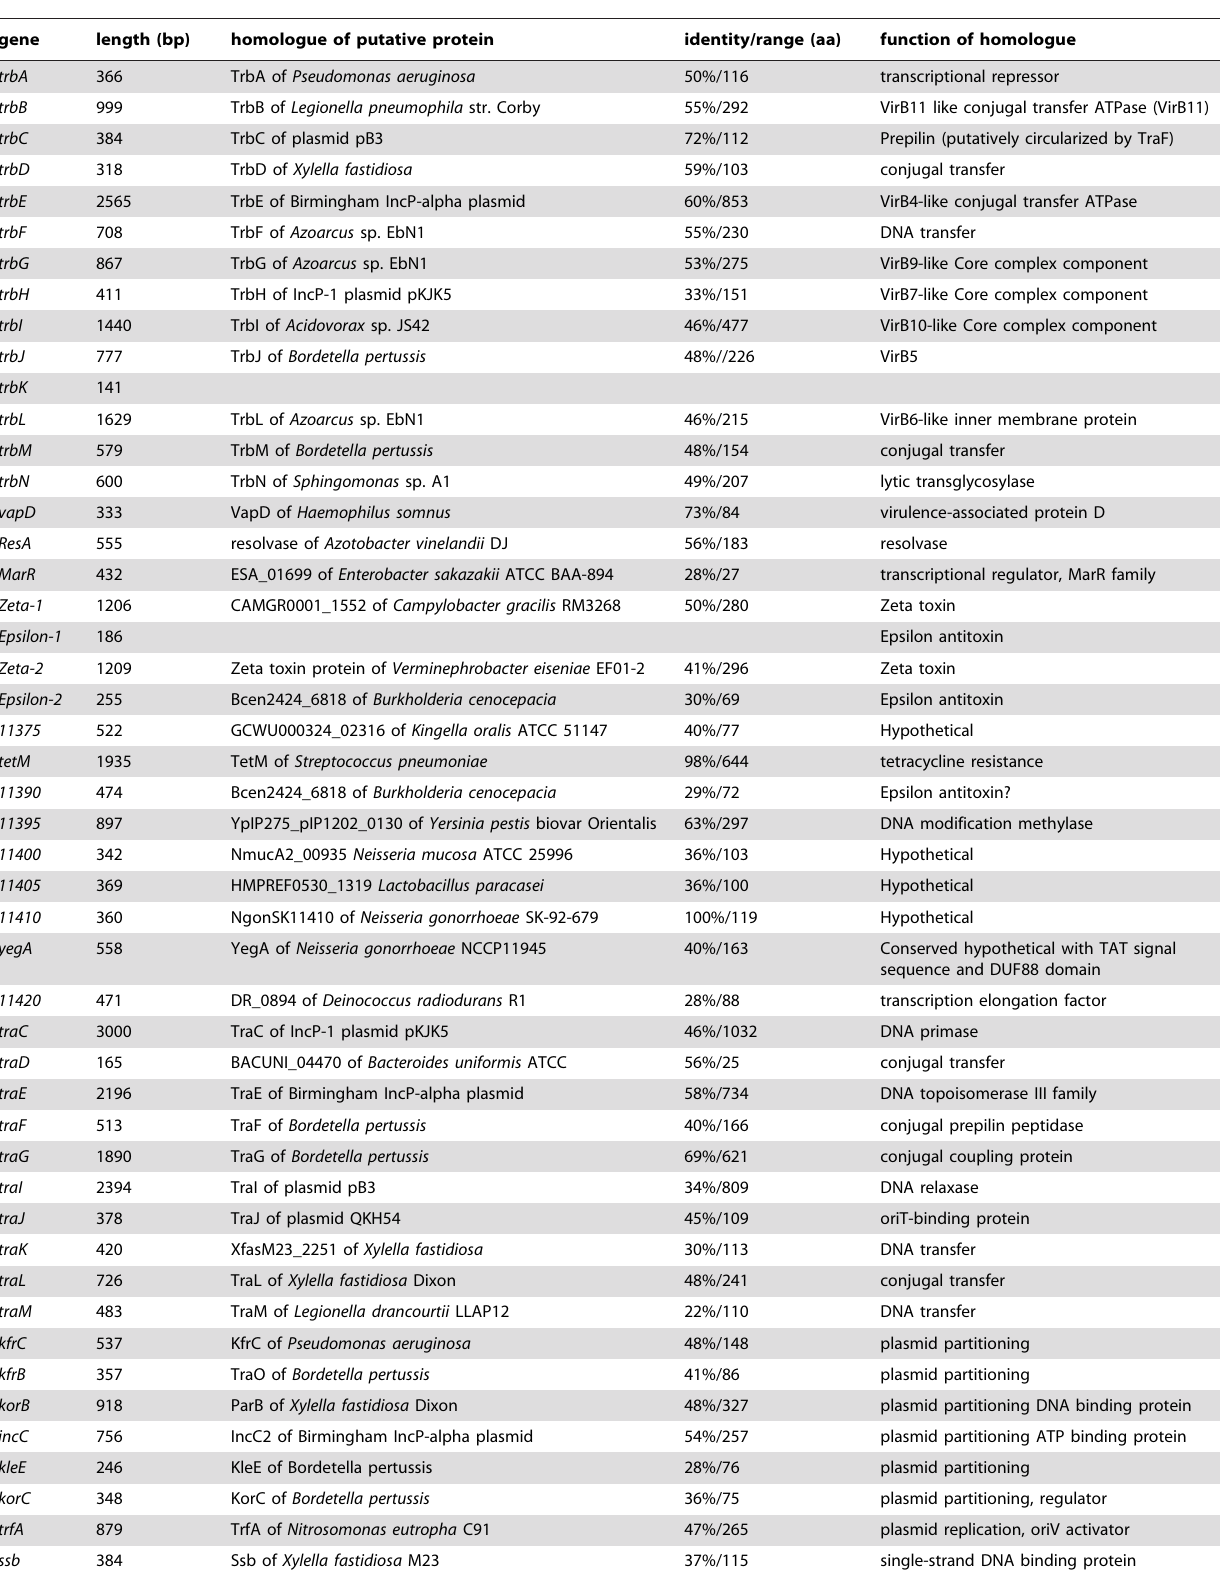
Table 2. Annotation of open reading frames located within the neisserial conjugative plasmid (pEP5289) with a Dutch type tetM determinant and a Dutch type